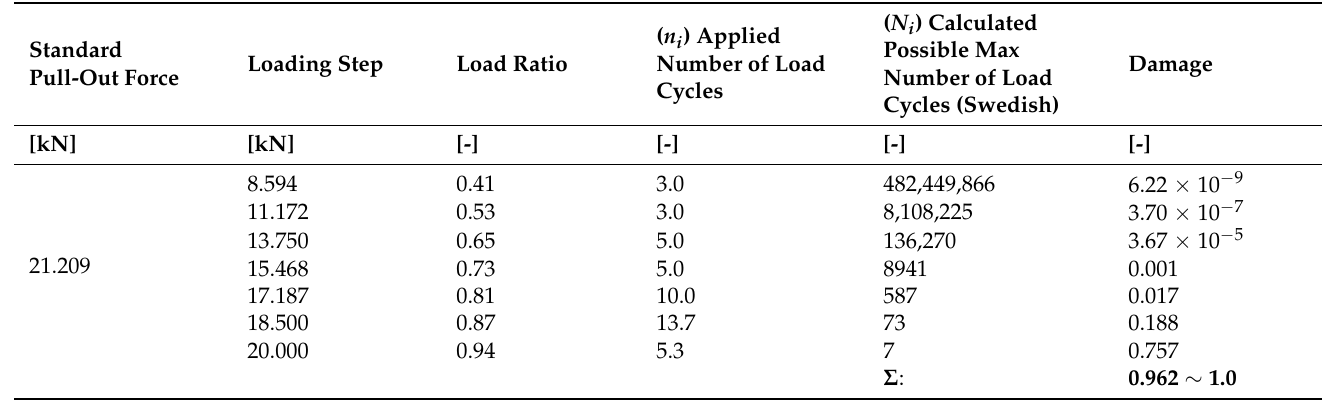
Table 7. Values of damage at different load levels (based on linear damage hypothesis)).